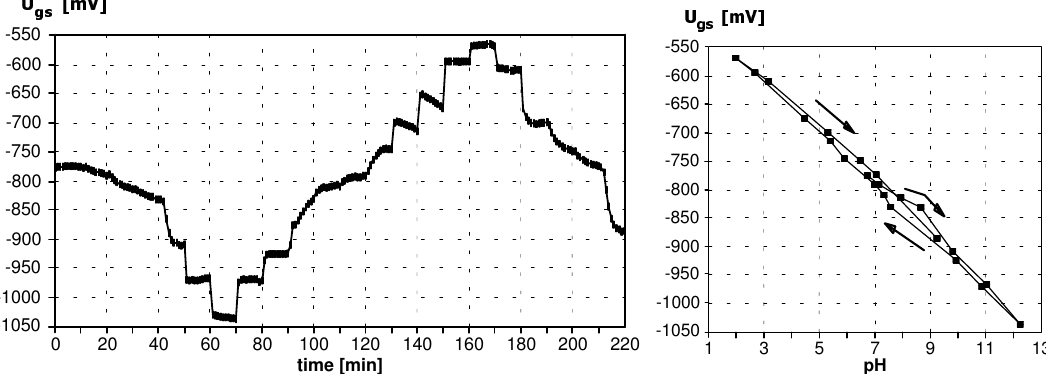
Figure 1. Response to pH changes of an ISFET with polyHEMA coating deposited according to the Method 2. Cycle of pH changes: